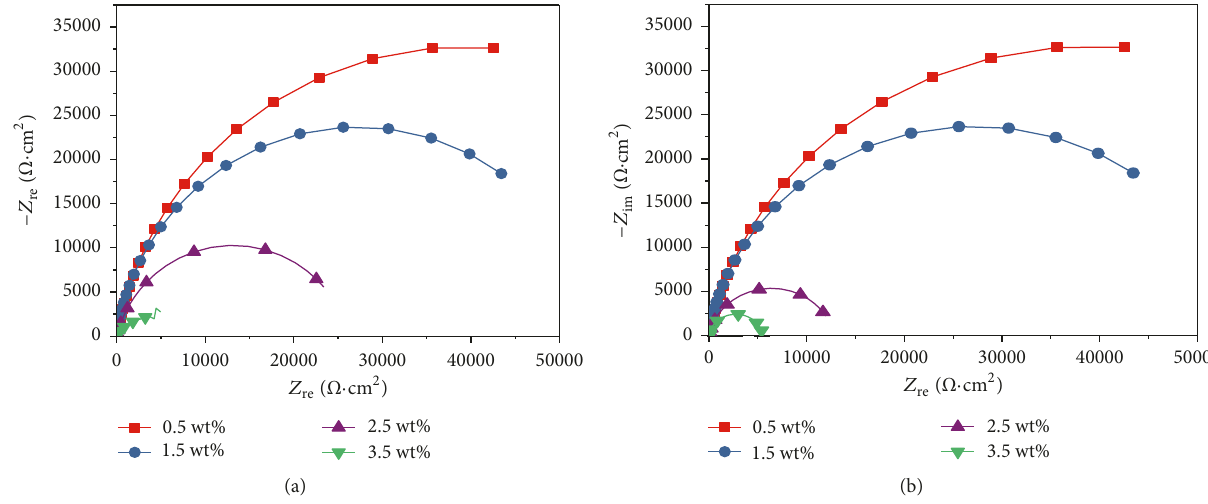
Figure 13: Influence of Cl − concentration on EIS profiles of (a) BM and (b)